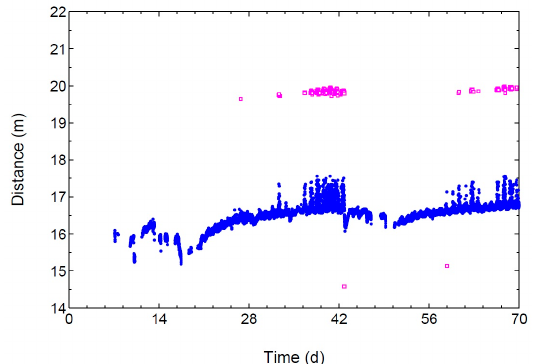
Figure A1. Raw distance data measured by the test Lidar, which are associated with a moderate ( I = 3, blue circles) or a low ( I = 2, purple squares) signal strength. Raw data associated with a low signal strength correspond to all the Lidar configurations (“first pulse”, “strongest pulse”, and “last pulse”).